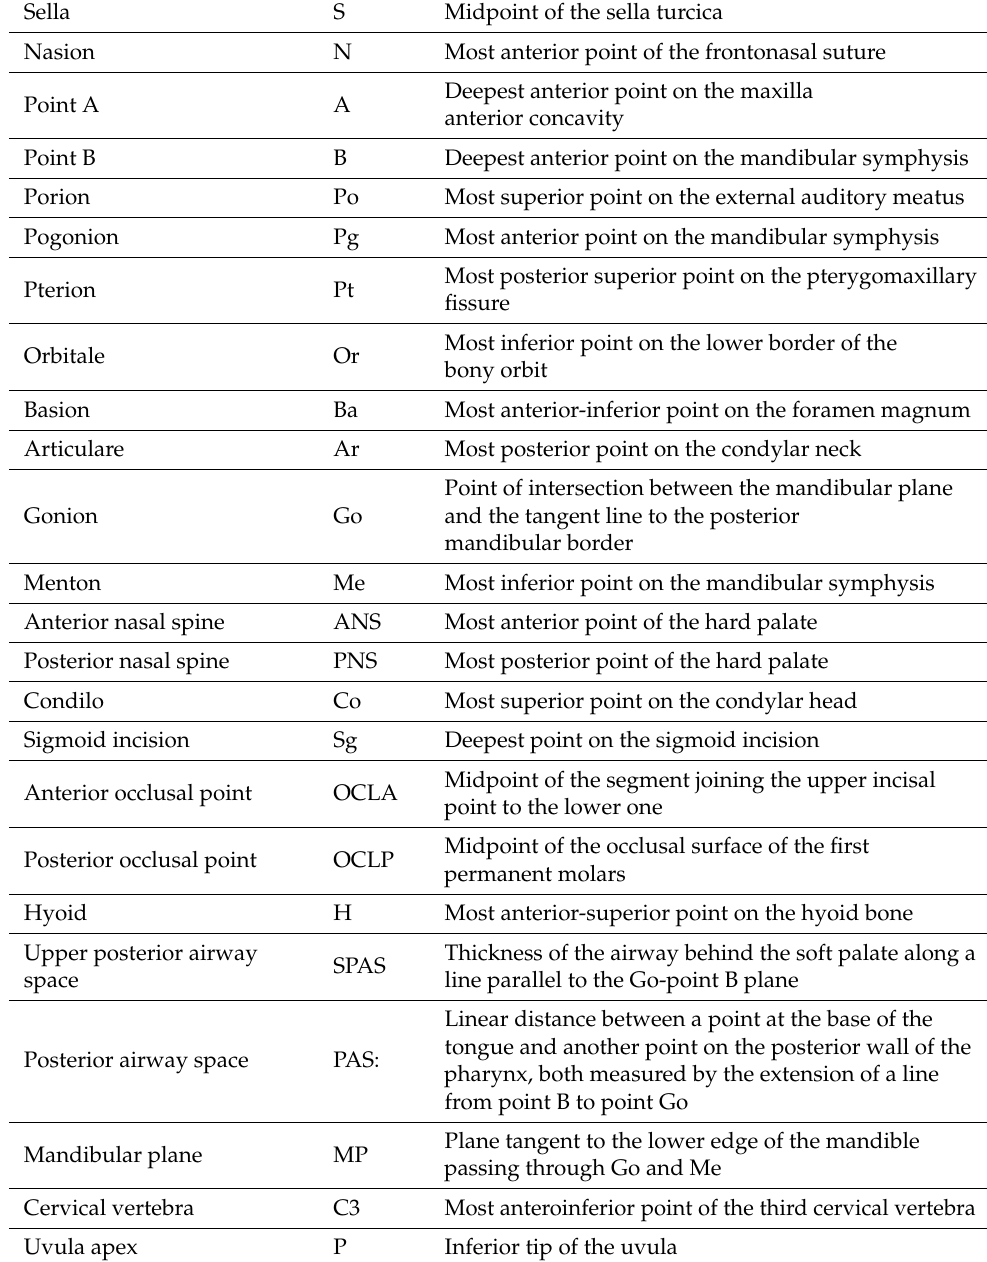
Table 1. Cephalometric points considered in the